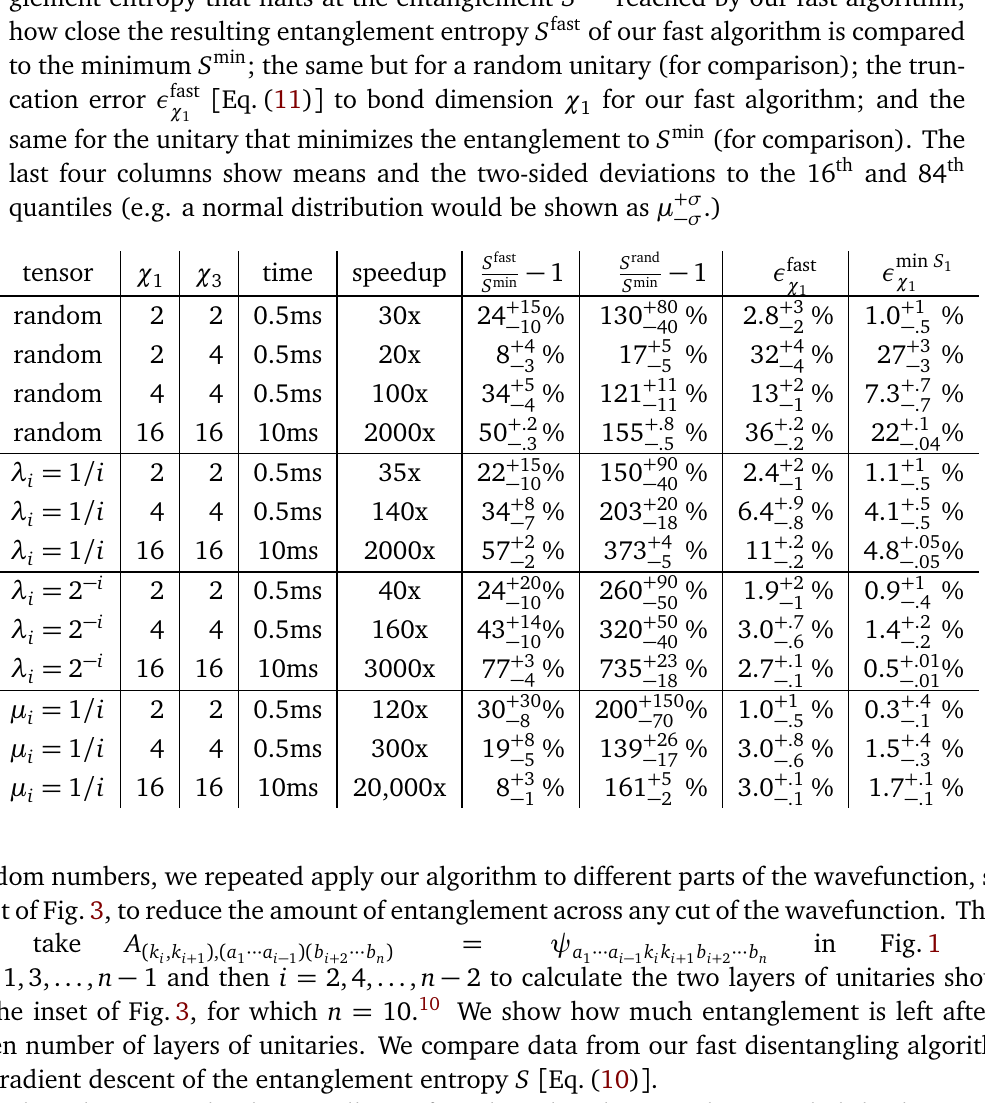
Table 1: For various kinds of tensors A [ defined in Eqs. (12)-(13) ] , where U · A has × χ × χ × χ dimensions χ , we list: rough CPU time of our fast algorithm; 1 1 3 3